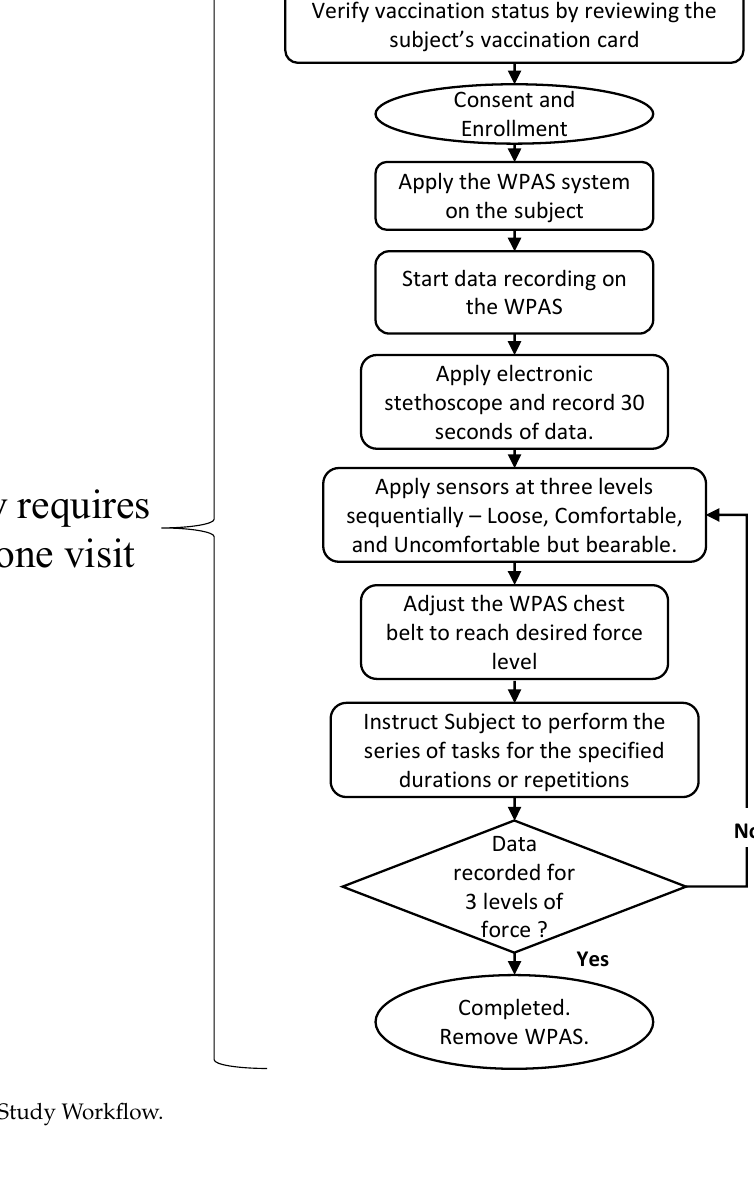
Figure 3. Study Workflow.